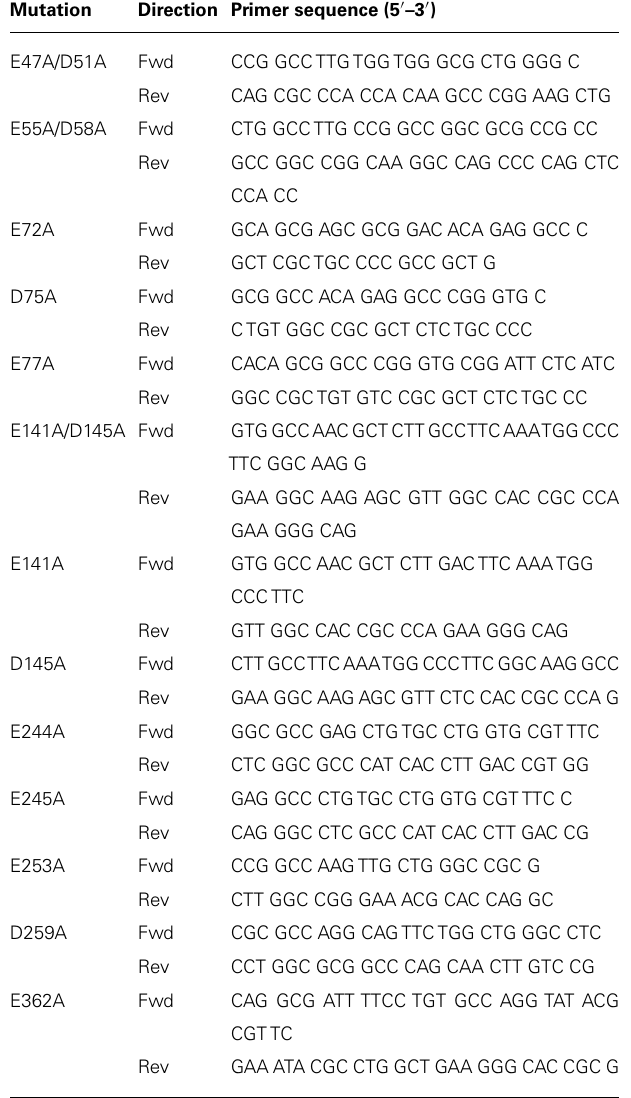
Table 2 | Site-directed mutagenesis primers for HA-RXFP3 D/E toA mutants. Mutation Direction Primer sequence (5 (cid:2) –3 (cid:2)